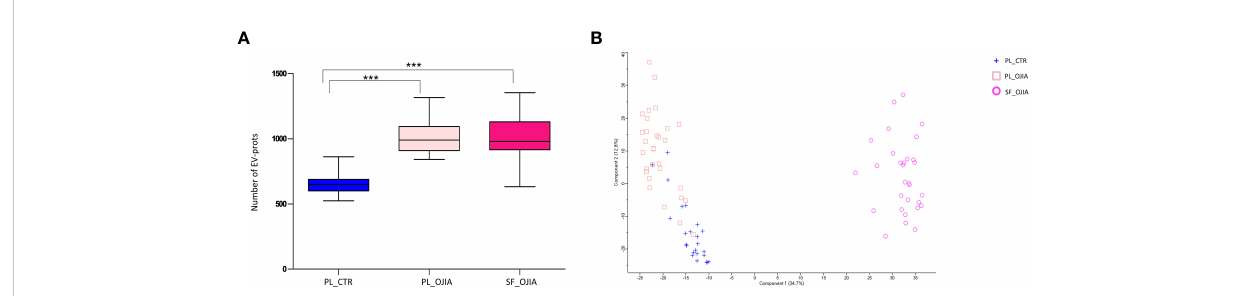
FIGURE 2 Comparative analysis of EV-prot expression pro fi les among SF_OJIA, PL_OJIA, and PL_CTR specimens. EV-prots were pro fi led in SF and PL from new-onset OJIA patients and PL from control children by LC-MS/MS. (A) The box plot indicates the average number of EV-prots detectable in the different biological groups. Boxes comprise the values falling between the 25th and 75th percentiles, median values are represented by horizontal lines, and the highest and lowest values for each group are represented by whiskers (lines that extend from the boxes). Statistical analysis using unpaired Student ’ s t-test was performed. P value of PL_CTR relative to OJIA PL and SF: ***p<001. (B) Principal Component Analysis (PCA) shows separation among different biological groups on the basis of the EV-prots expression pro fi les. The percentage of the total variation accounted for the fi rst and second components is shown on the x and y axes, respectively. Blue crosses, pink squares, and fuchsia circles refer respectively to PL_CTR, PL_OJIA and SF_OJIA. PL and SF groups form two clusters on Principal Component 1 (PC1) showing high differences at the proteome level. OJIA_PL and PL_CTR partially cluster on